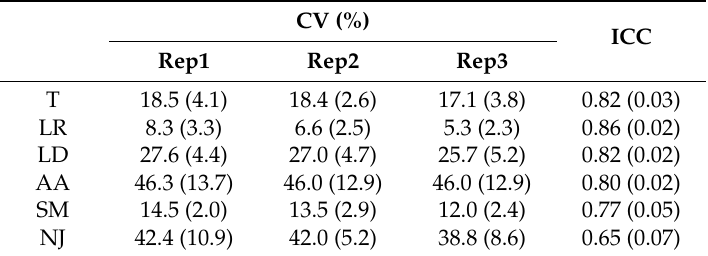
Table 1. Mean and standard deviation of CV values for all the indices (Duration of movement (T), Length ratio (LR), Lateral Deviation (LD), Aiming angle (AA), Speed metric (SM), Normalized jerk (NJ)) among forces, directions and subjects, calculated for each day repetition, and Mean and standard deviation of ICC for each index among forces, directions, repetitions and subjects. CV